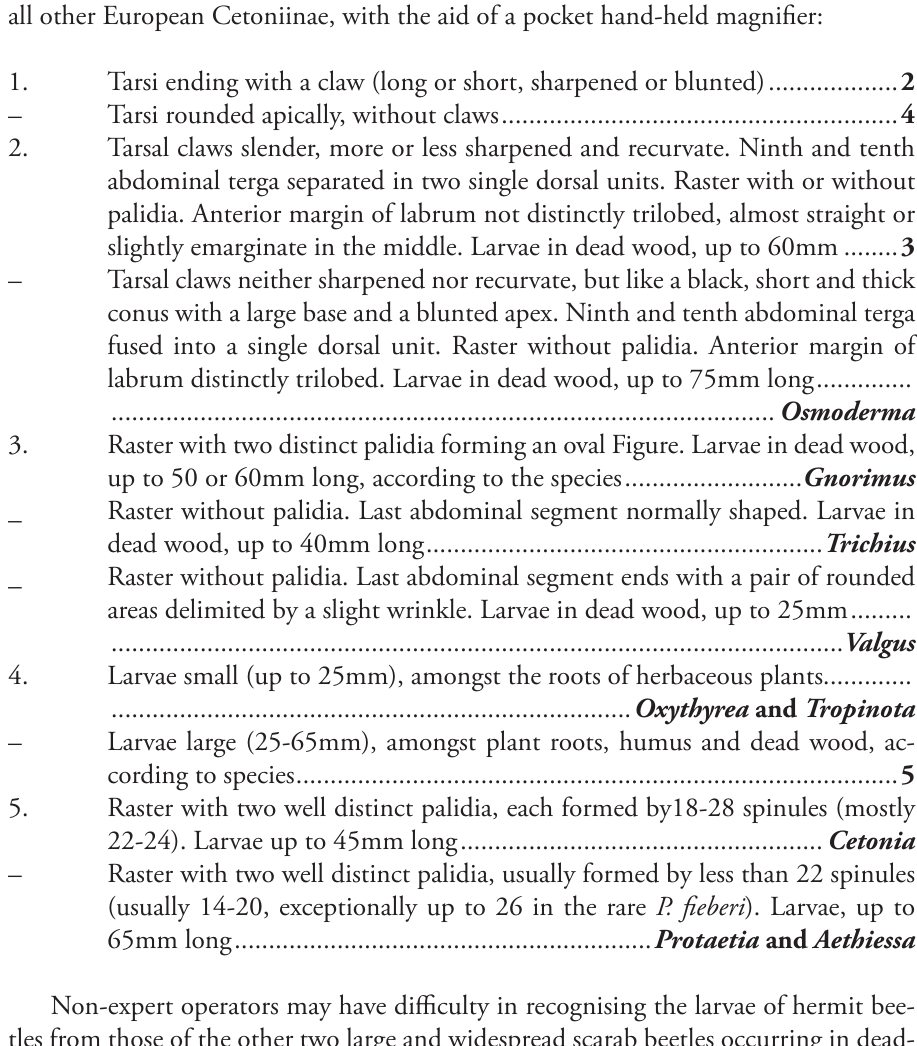
Non-expert operators may have difficulty in recognising the larvae of hermit bee- tles from those of the other two large and widespread scarab beetles occurring in dead- wood i.e. Oryctes (Scarabaeidae Dynastinae) and Lucanus (Lucanidae Lucaninae). Apart from microscopy characters involving antennae and mouth parts, often very hard to detect during the fieldwork, the larva of Oryctes is easily distinguished because its last abdominal segment is divided into two halves by a transverse narrowing, so that, in dorsal view, the abdomen seems to be formed by ten clearly observed segments. On the other hand, the larva of Lucanus is immediately recognisable by the abdominal terga not plicate, the longitudinal anal slit (instead of the transverse anal slit of Osmoderma and other Cetoniinae), the large but much narrower and elongate abdominal spiracles (see Bardiani et al. 2017) and the stridulating organs consisting of a series of teeth